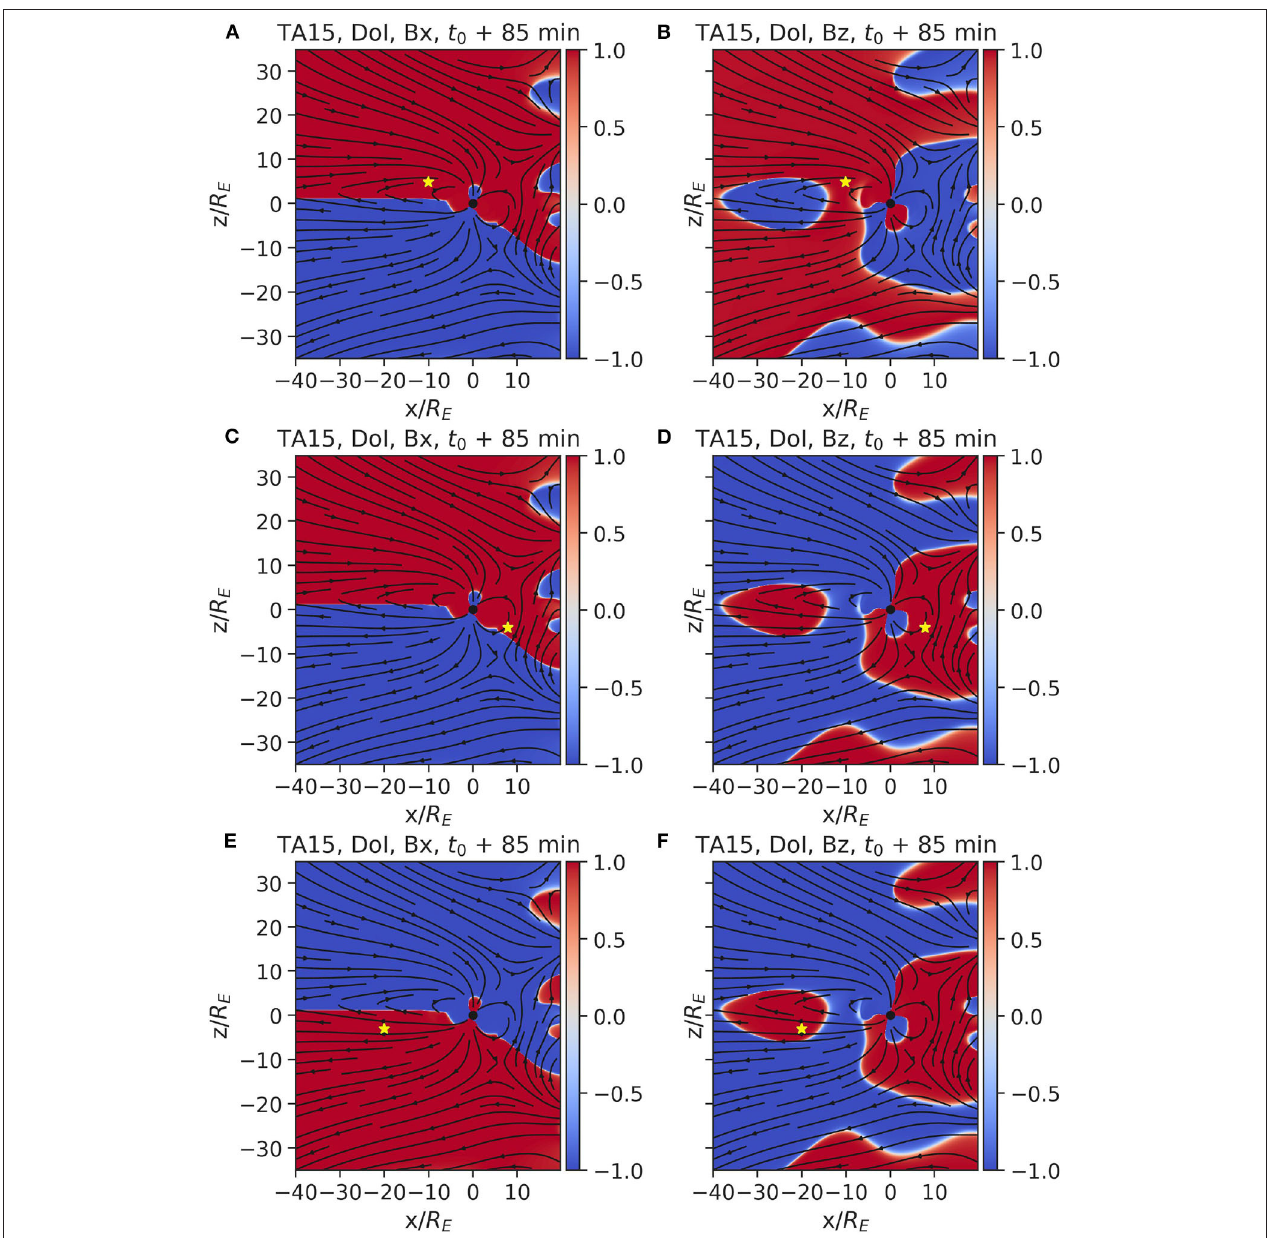
FIGURE 9 | DOI maps for B x (A,C,E) And B z (B,D,F) , computed from an ensemble of Tsyganenko TA15 simulations at t 0 + 85 min with observation points at the same position as Figure 7